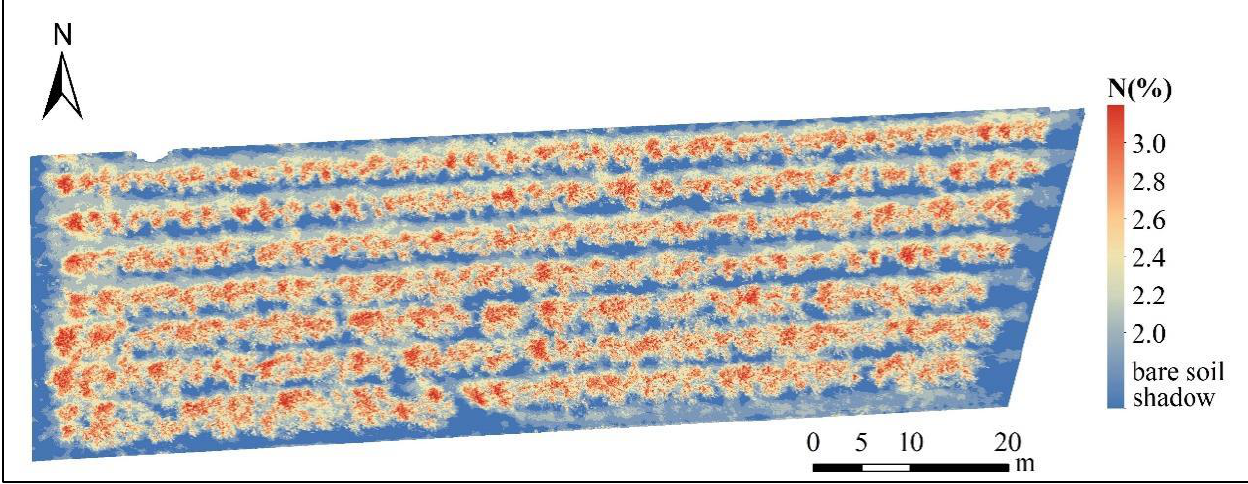
Figure 5. Distribution map of CNC in apple canopy.